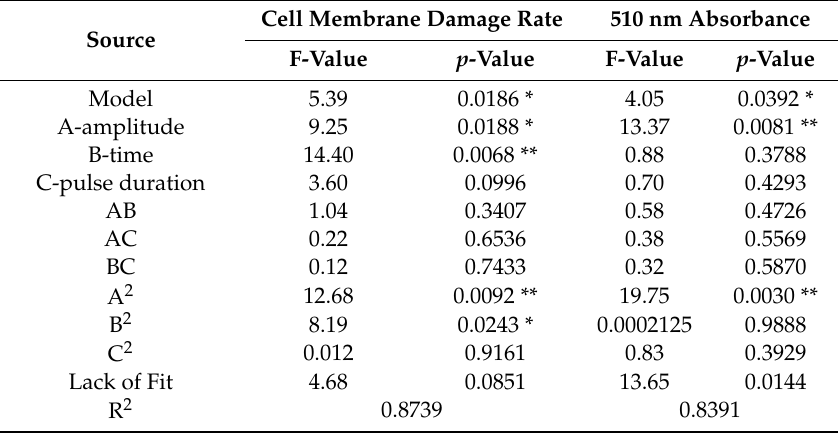
Table 4. Response surface variance analysis